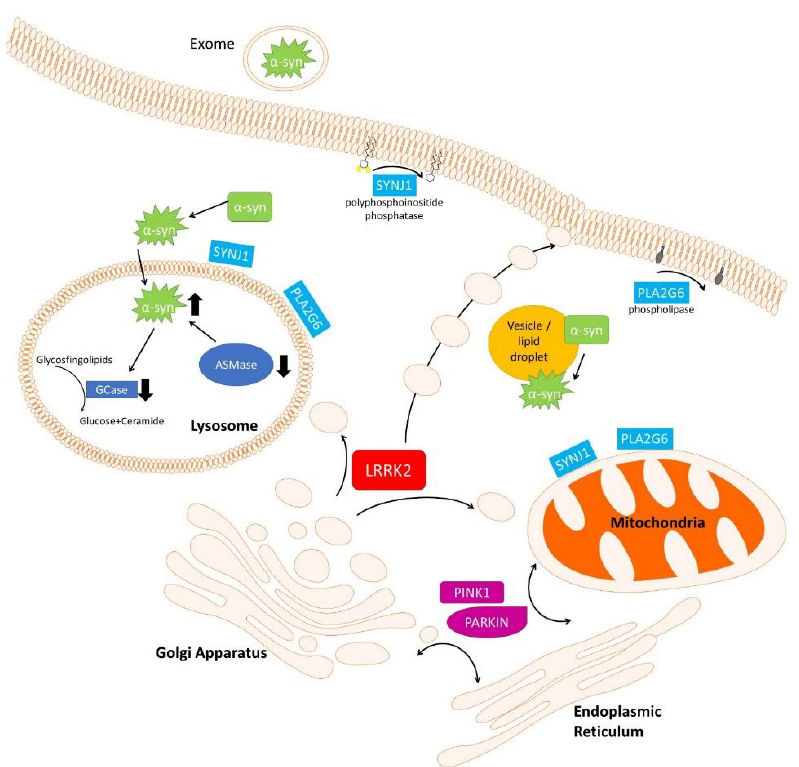
Figure 1. Cell biological processes impacted by PD-related genes leading to lipid alteration. As described in the main text, different PD-causative or -risk genes (GBA, SMPD1, SYNJ1, and PLA2G6) directly control lipid metabolism in neuronal cells. PD-causative genes (LRRK2, PINK-1, and PARKIN) may indirectly control lipid metabolism, localization or signaling by controlling vesicle trafficking and/or lipid exchange between various organelles inside the cells. Finally, α -synuclein physiology is tightly related to lipid: α -synuclein controls lipid metabolism, α -synuclein localization and aggregation are strongly dependent on a specific membrane lipid composition, and, lastly, LBs are largely composed of α -synuclein tightly associated to lipids and membrane fragments. Aggregated α -synuclein is represented as green